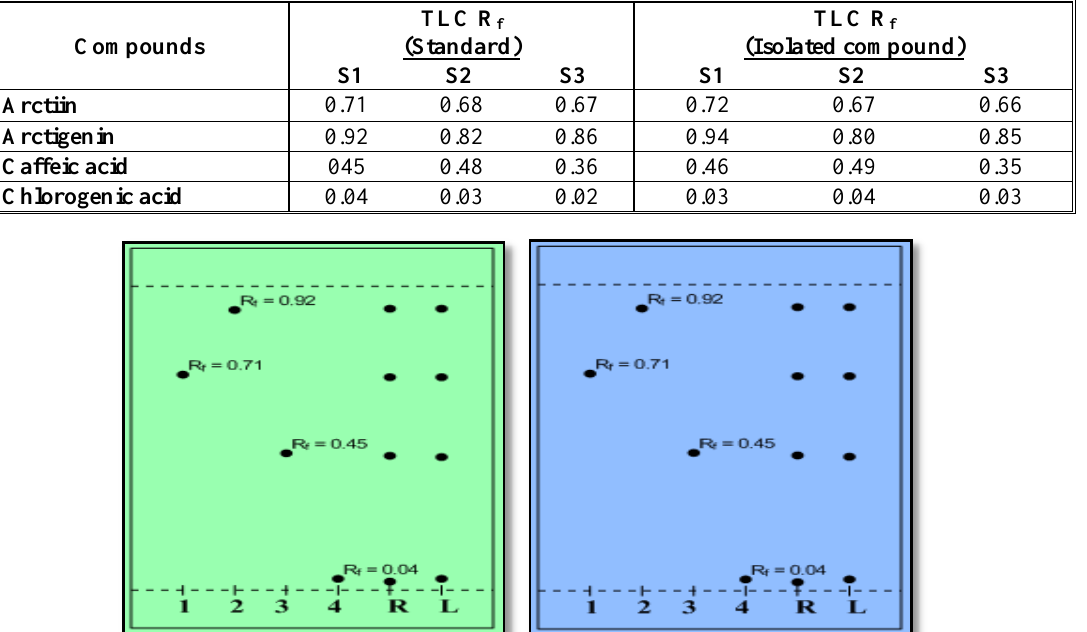
Identification Table 2: R values of some plant constituents and their standards in different developing solvent f systems in TLC .